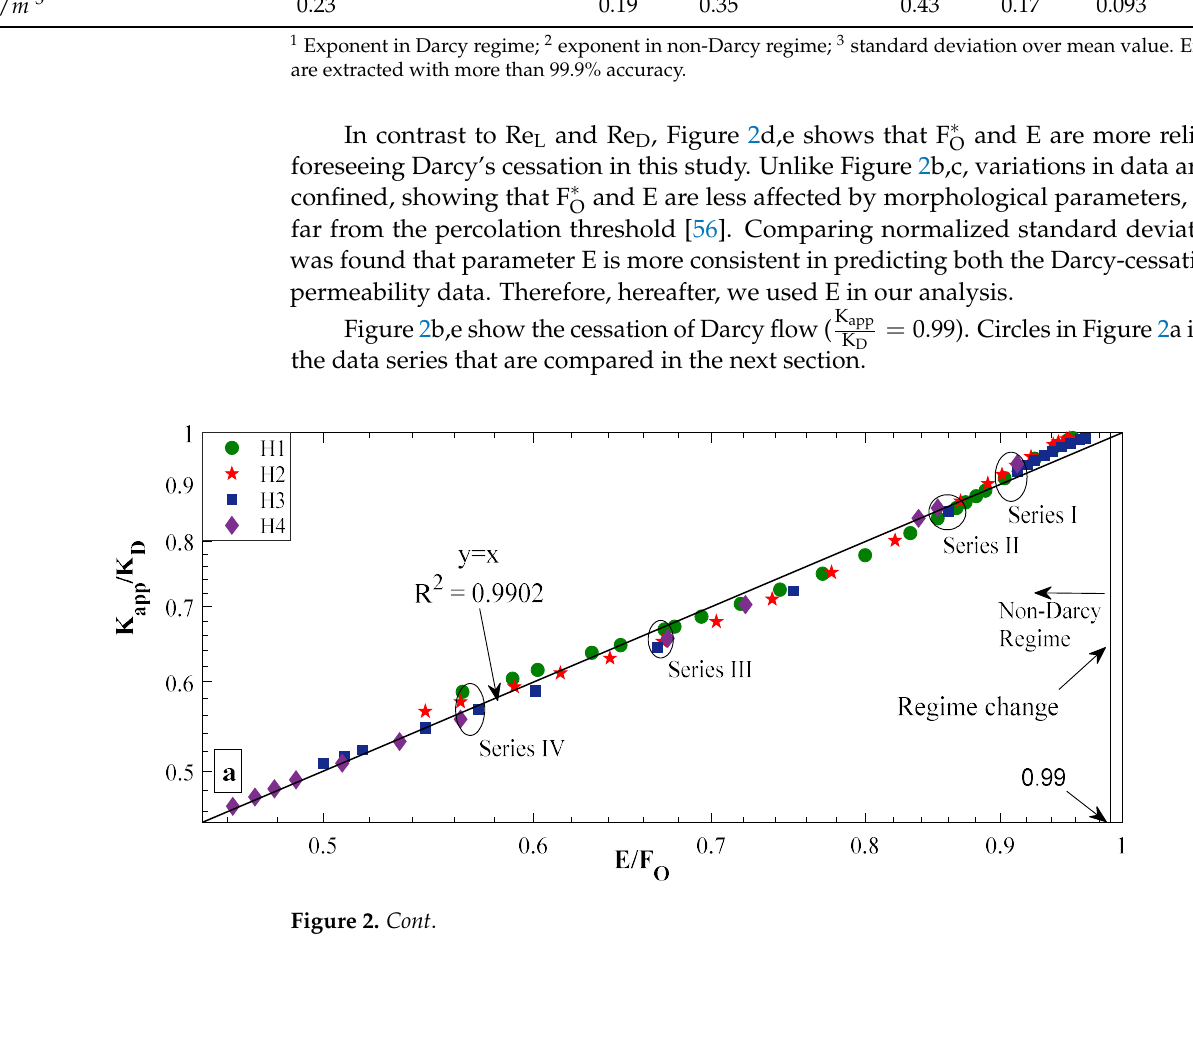
2b,c plots dimensionless permeability versus Re (cid:2922) and Re (cid:2888) , respectively.